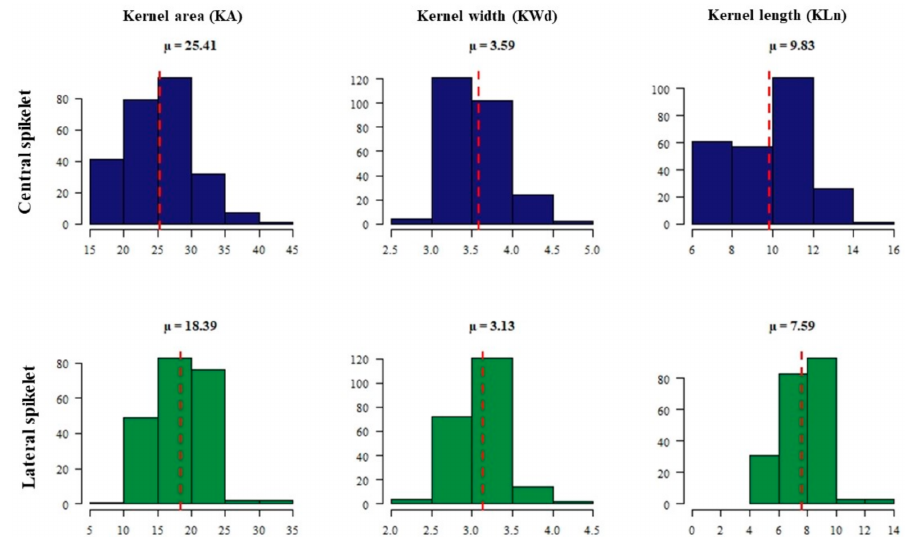
Figure 2. The phenotype’s frequency distribution histogram of kernel area (KA), kernel width (KWd), kernel length (KLn) and spikelet awn length (SAL) for central (blue color) and lateral (green color) spikelets among 254 intermedium -spike barley